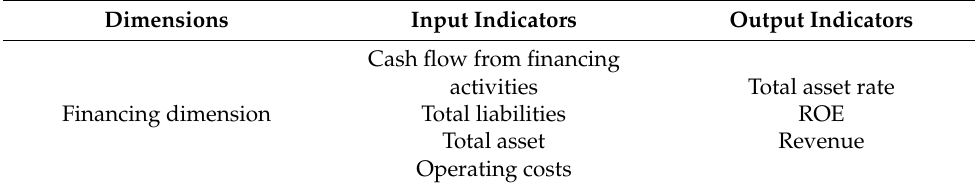
Table 4. Financing dimension evaluation index system.